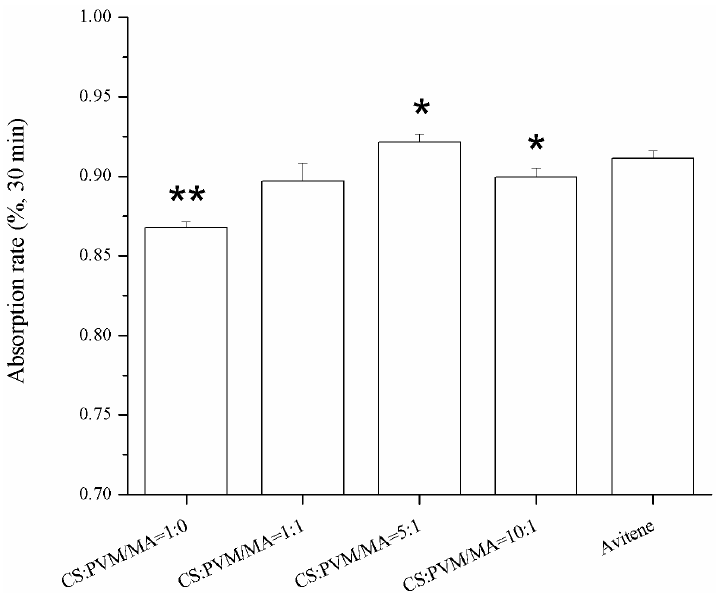
Figure 6. Water absorption rate of different sponges. The “*” indicates a significant difference between the prepared sponge and Avitene when p < 0.05, while the “**” indicates a significant difference between the prepared sponge and Avitene when p < 0.01 (Student’s t-test, n =